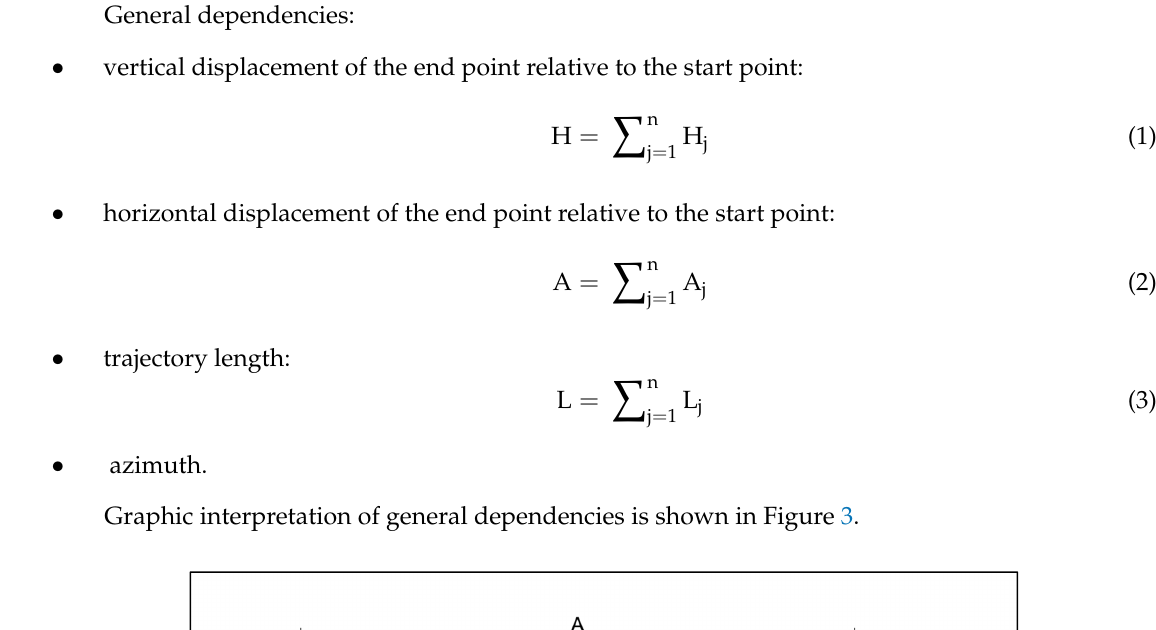
Figure 2. Reference system used when designing HDD trajectories in two–dimensional space.